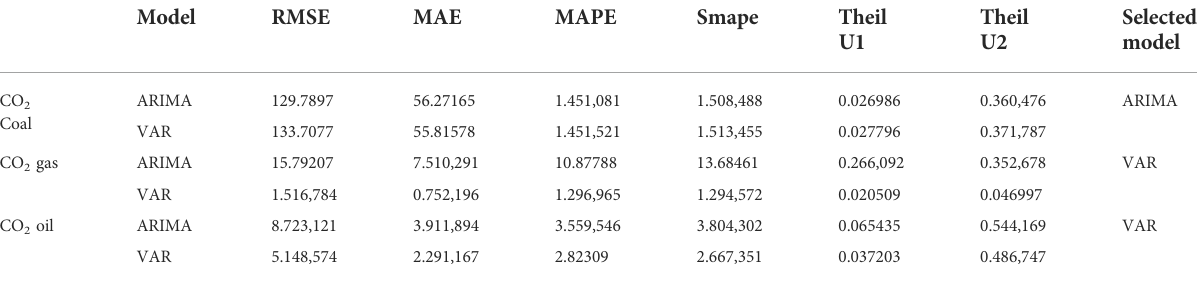
TABLE 8 Comparing the power of both ARIMA and VAR model in predicting CO 2